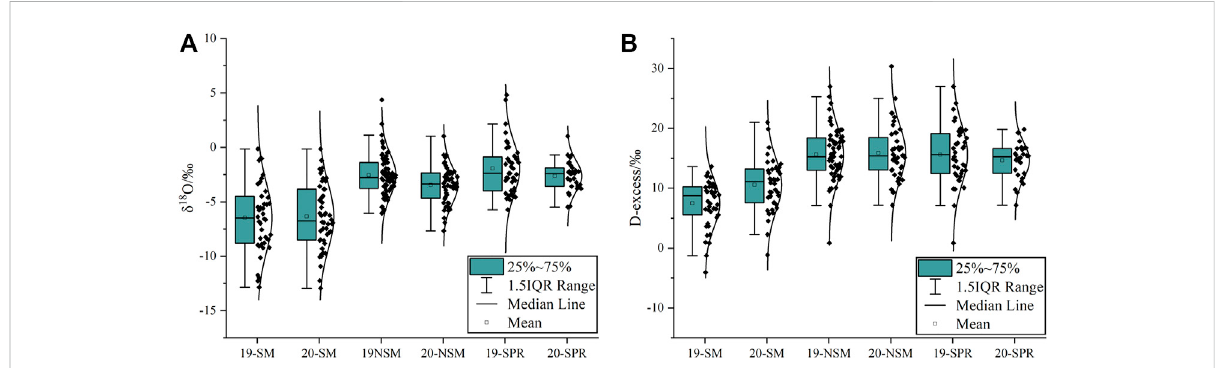
FIGURE 4 Seasonal variations of precipitation (A) δ 18 O, and (B) d- excess in different periods. Boxes represent the 25% – 75% percentiles, and whiskers indicatethe10thand90thpercentiles.Thesquaresstandintorepresentthearithmeticmean,whilethelinethroughtheboxre fl ectsthemedian.The distribution curves and individual data points are plotted as